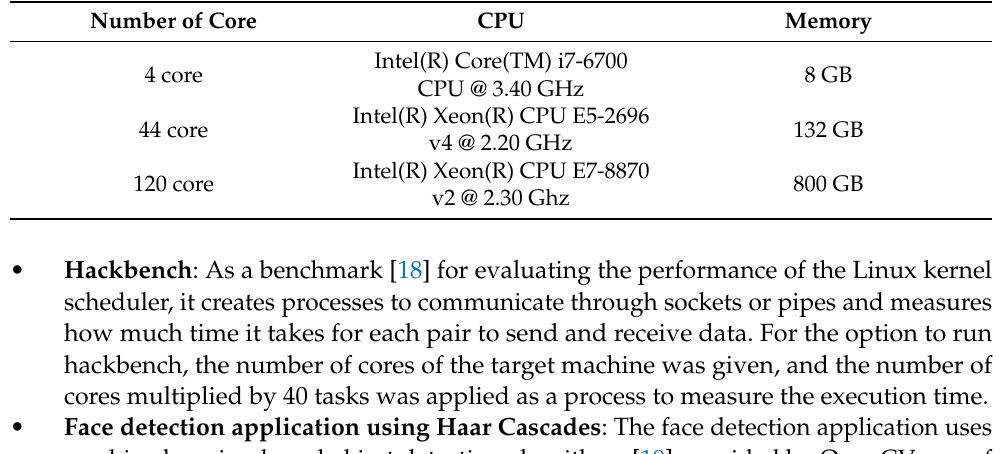
Table 2. Experimental machine